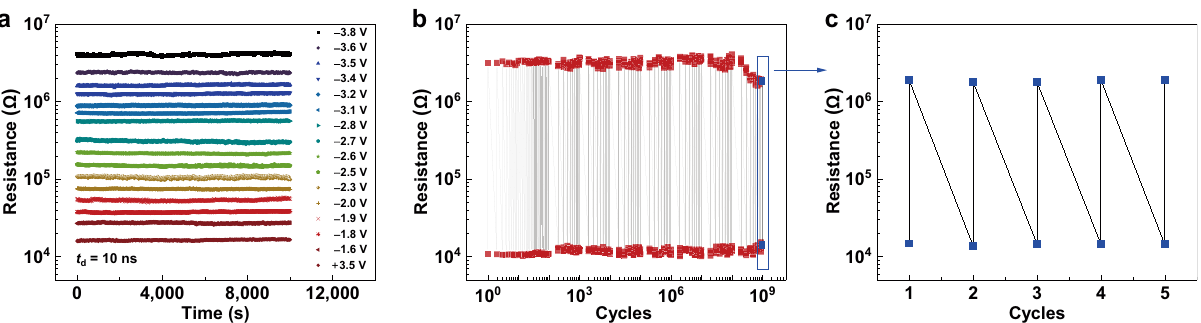
Fig. 5 Retention and endurance measurements of the FTJ with a (111)-oriented PZT barrier. a Retention time of representative 4-bit resistance states. b Endurance by applying + 2 V/ − 3 V with pulses of t d = 100 ns. c 5 resistance switching cycles after the 10 9 cycles.